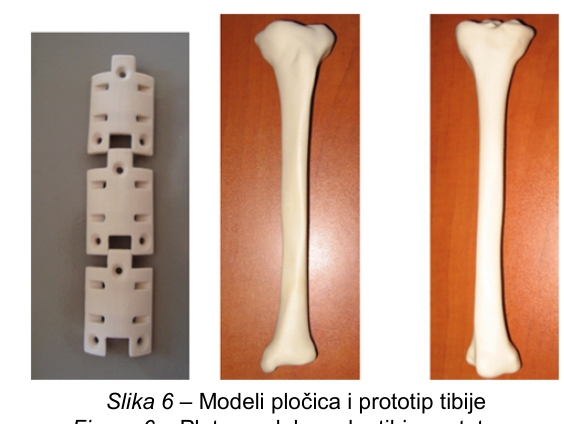
Figure 6 – Plate models and a tibia prototype